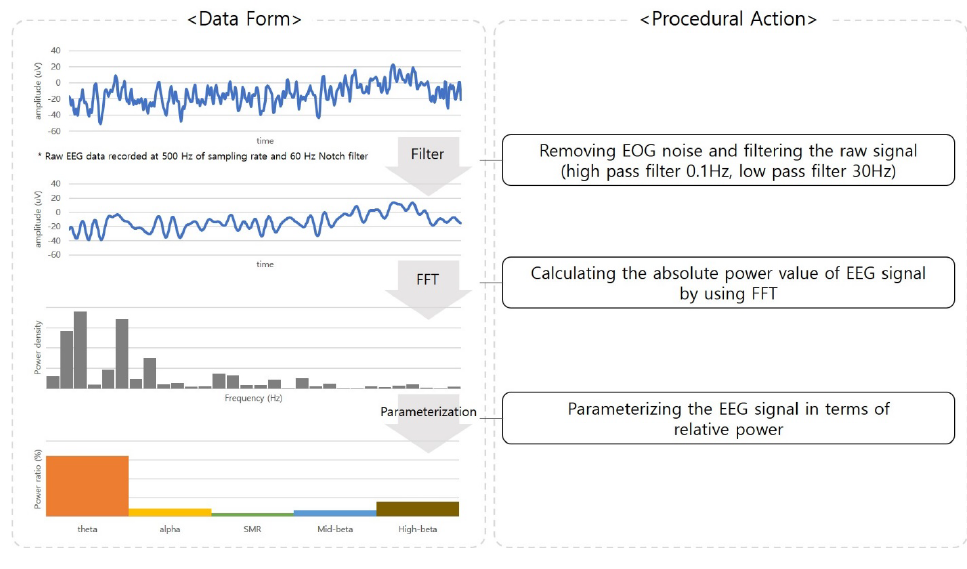
Figure 3. Preprocessing of the EEG data.